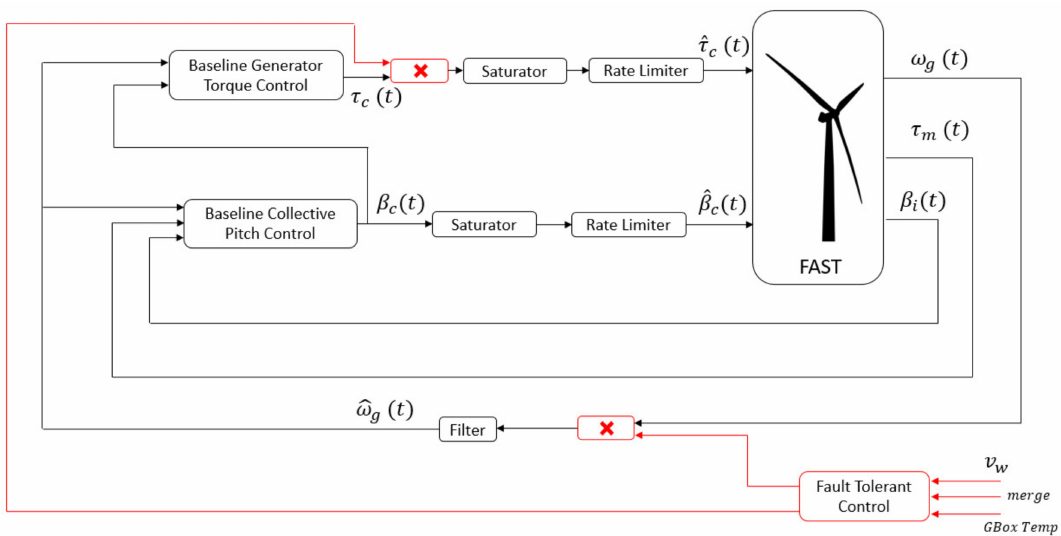
Figure 5. The proposed Fault-Tolerant